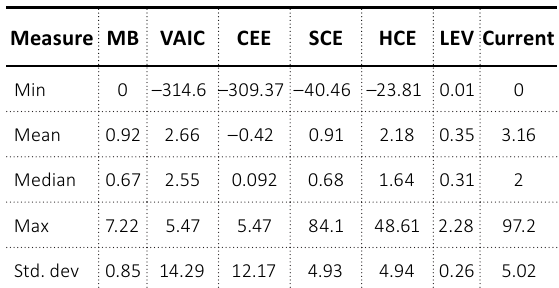
Table 1. Descriptive